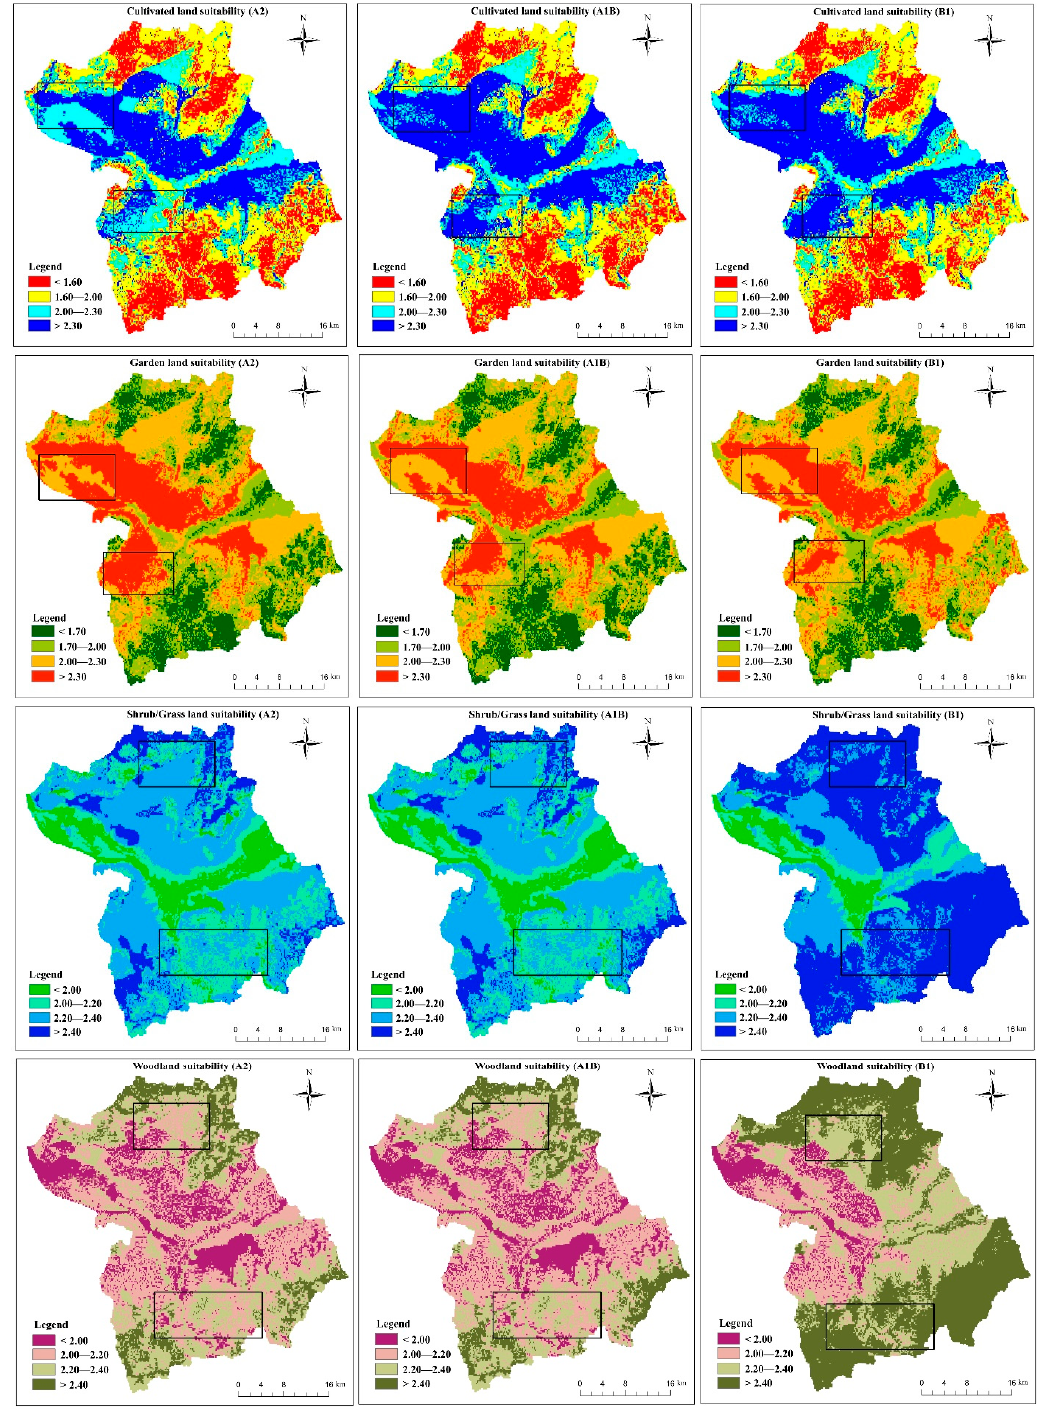
Figure 3. Land use suitability evaluation result.